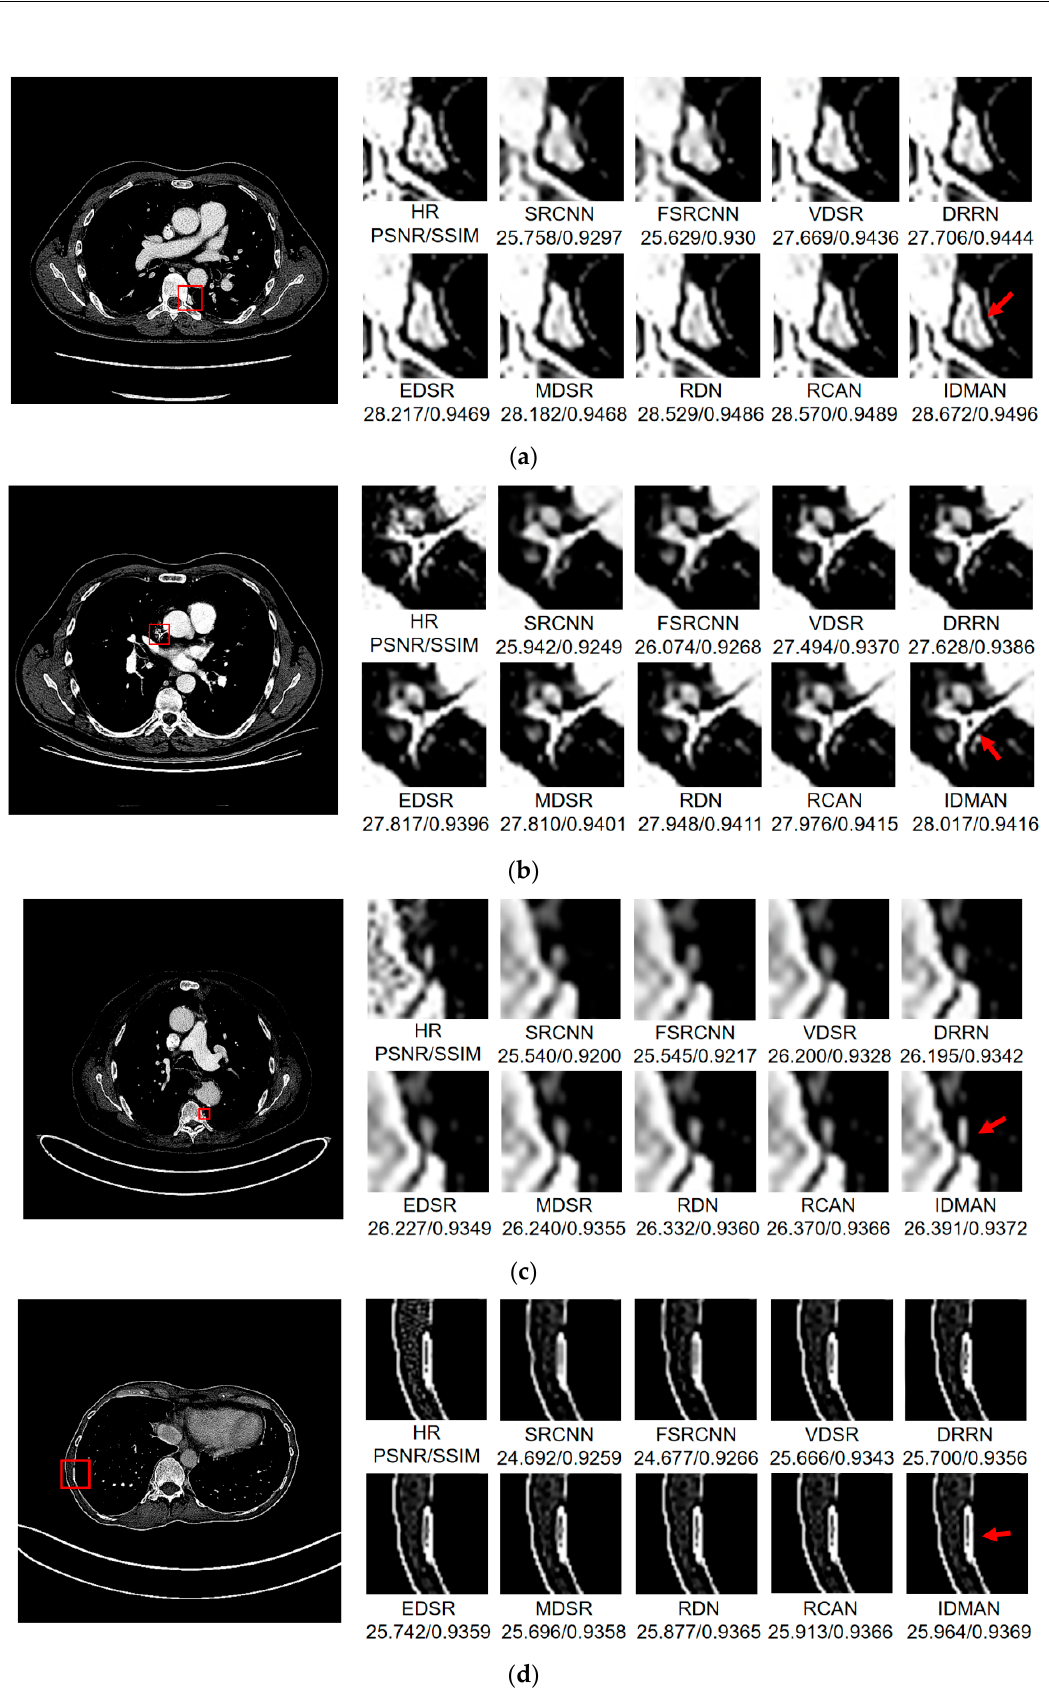
Figure 8. Images ( a – d ) show the visual results of different algorithms on DeepLesion testing set for scaling factor × 2 .